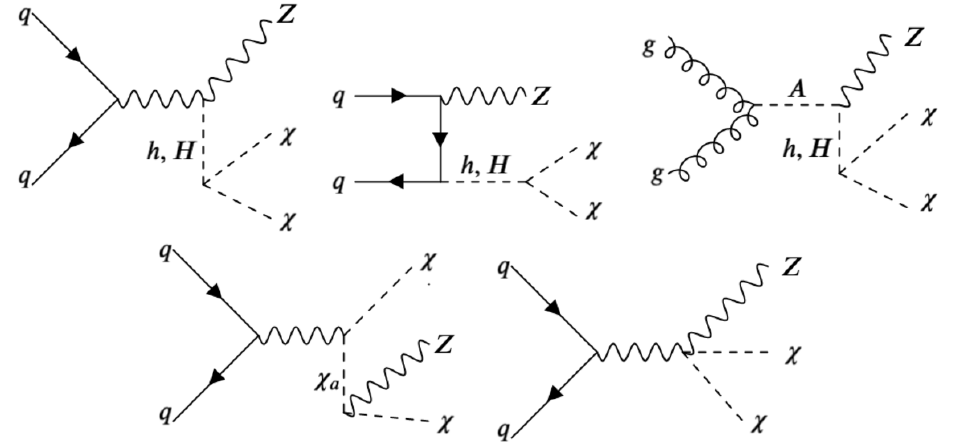
Figure 7 . Feynman diagrams contributing to the mono Z process.